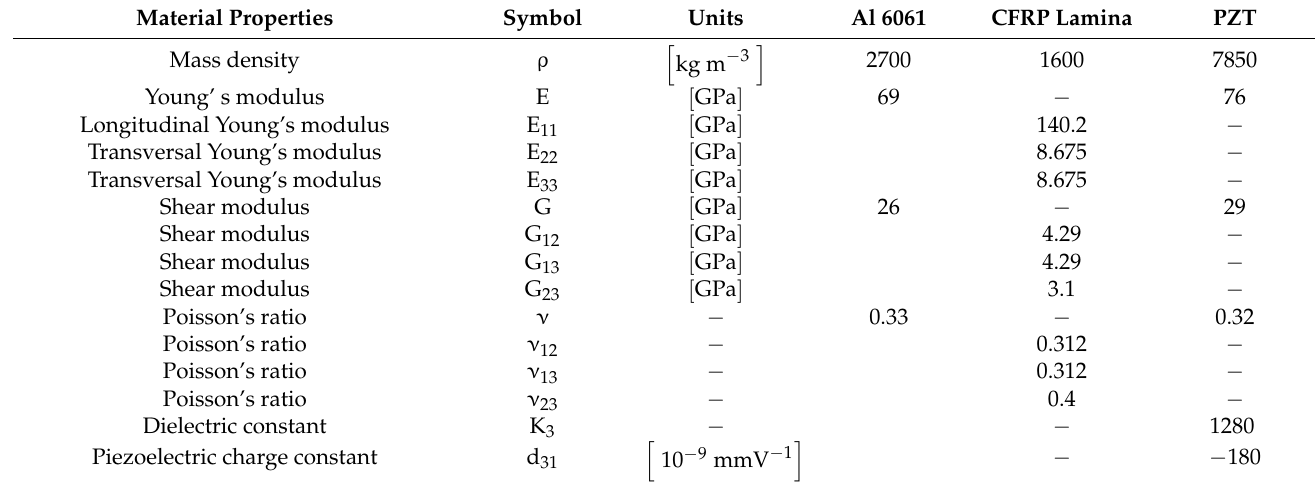
Table 1. Material properties of Al 6061 plate, CFRP composite lamina, and PIC255 sensors.